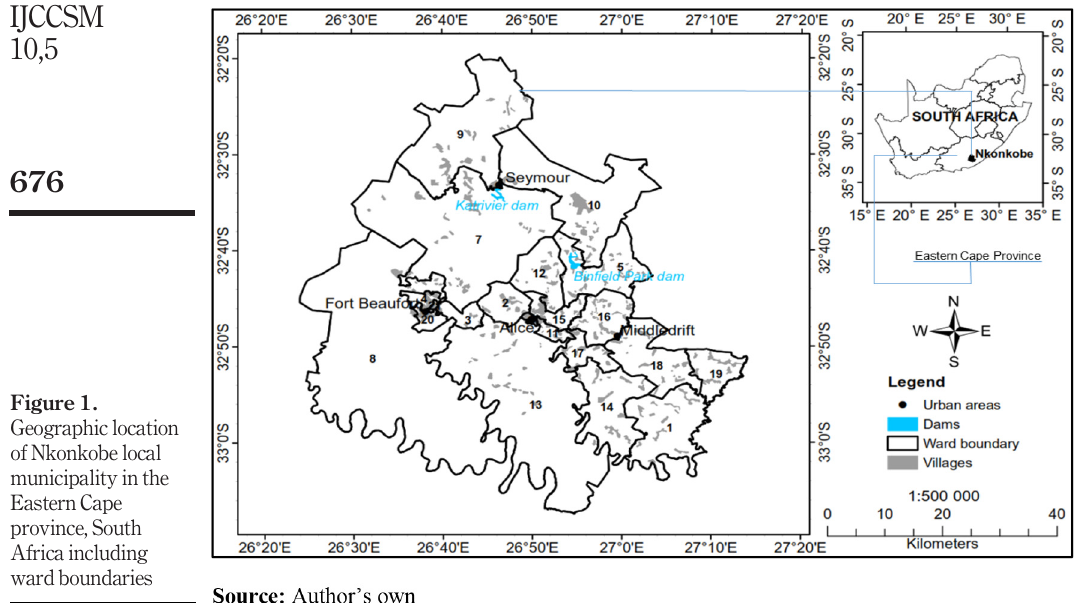
Figure 1. Geographic